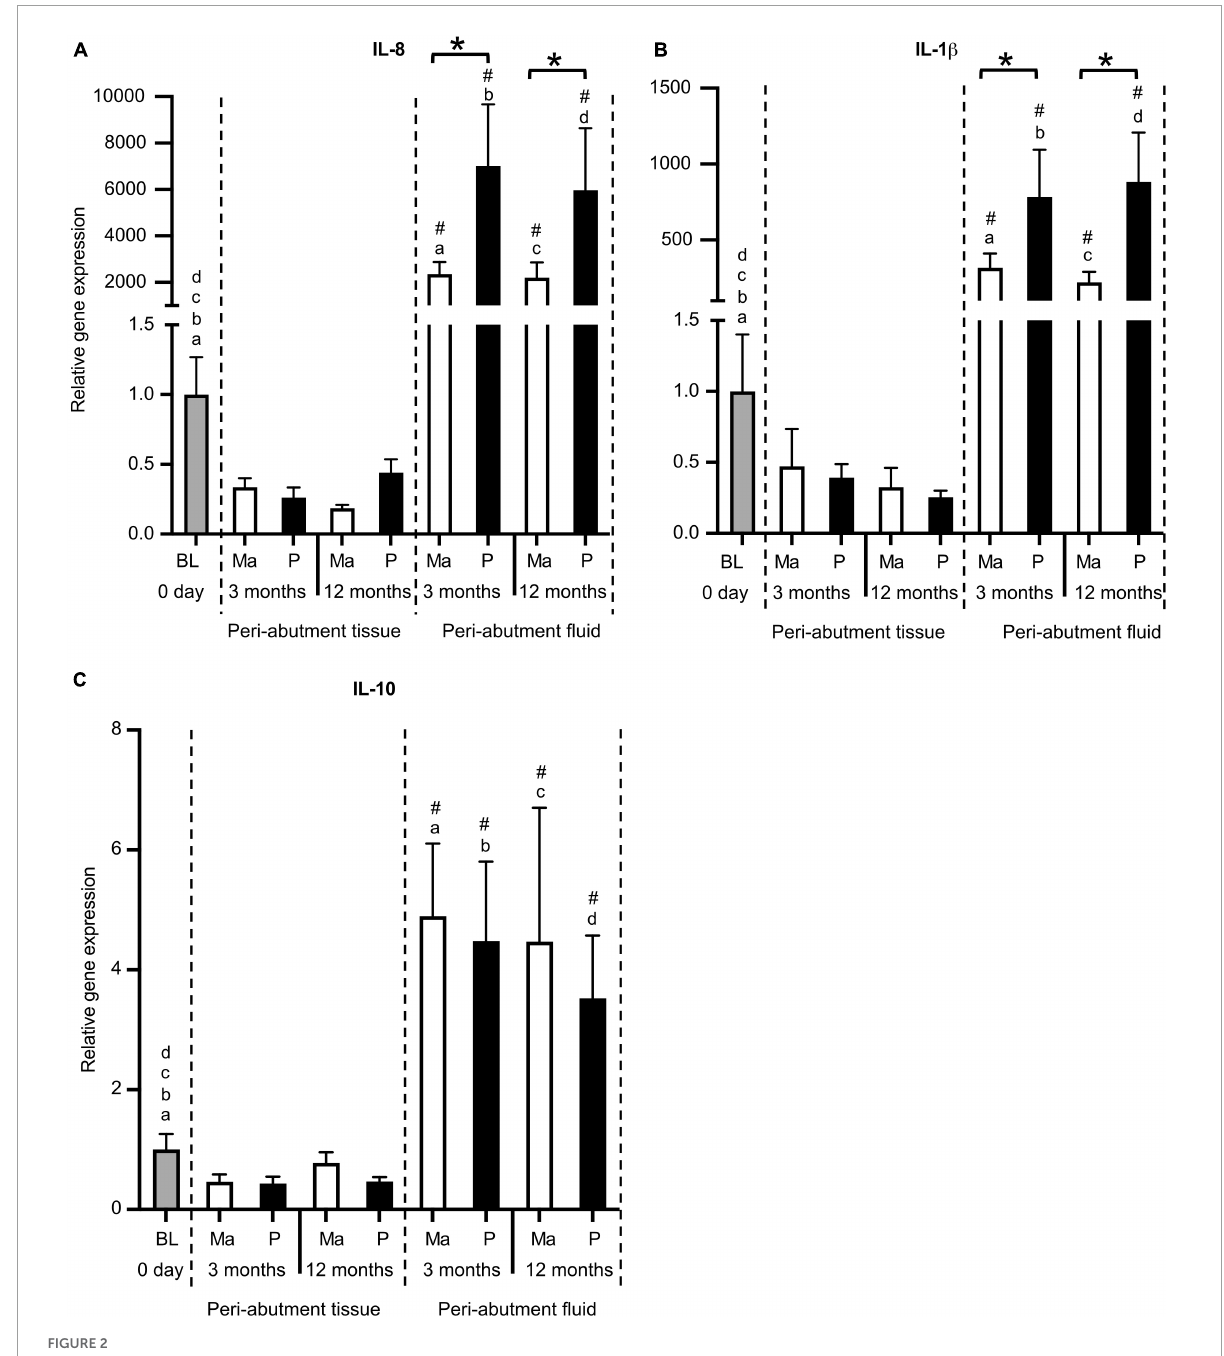
FIGURE2 Gene expression of inflammatory cytokines. (A) Proinflammatory cytokine interleukin-8 (IL-8). (B) Proinflammatory cytokine interleukin-1beta (IL-1 β ). (C) Anti-inflammatory cytokine interleukin-10 (IL-10). The column graphs show the relative gene expression at baseline (BL) and in the peri-abutment tissue and peri-abutment fluid at machined (M) and electropolished (P) abutments after 3 and 12 months of implantation. Statistically significant differences ( p < 0.05) between BL and either compartment (“Peri-abutment tissue” or “Peri-abutment fluid”) and between the two compartments are indicated by similar small letters and hash signs, respectively. The differences between machined and electropolished abutments for each compartment are indicated by bars and asterisks.